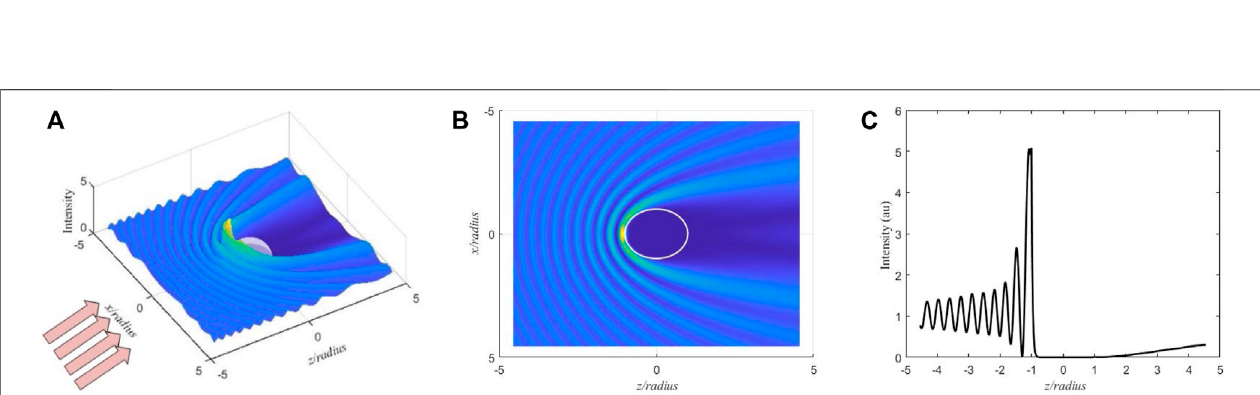
FIGURE 4 | (A) The distribution of internal and near fi elds variation with the plasma frequency and (B) the maximum intensity of the evanescent wave versus the plasma frequency with f i = 2.1 GHz and ] c = 4 GHz.